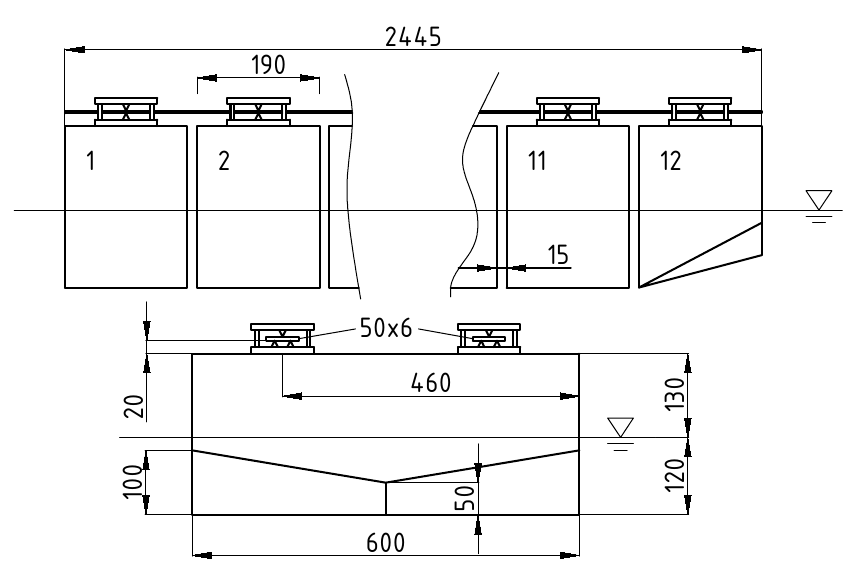
Figure 1. The geometry of the flexible segmented barge (dimensions are in